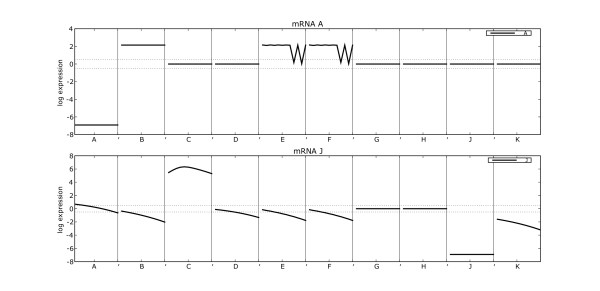
Log-ratios of mRNA concentration values for all knockout experiments. Log-ratios of mRNA concentration values of genes A and J for all knockout experiments. 12 time points in equal length intervals between 1100 and 1600 minutes are taken from each experiment (120 slices together). Ratios lower than 0.001 were set to this value. The horizontal lines indicate the top and bottom limits of the baseline expression level. Extended version of the figure including all 10 genes is available in the supplementary materials [25].